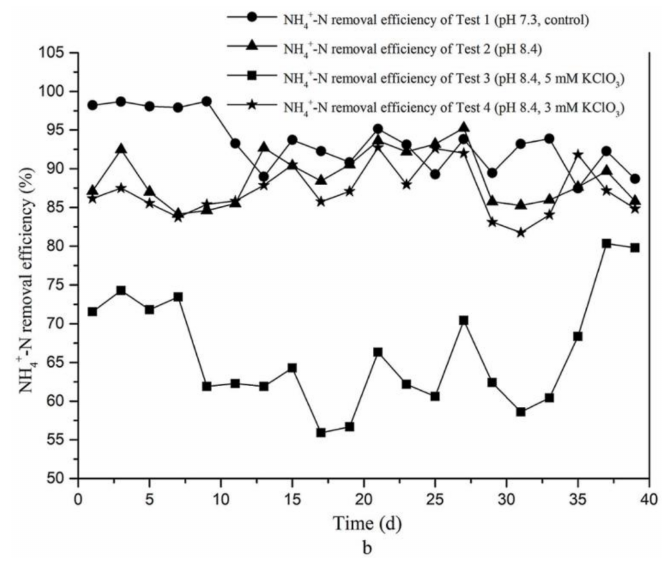
Figure 5. Ammonium-nitrogen removal. ( a ) Absolute concentrations of NH 4 + -N in effluent and influent; ( b ) Ammonium-nitrogen removal efficiency (in %) of the four experimental tests of CRI.